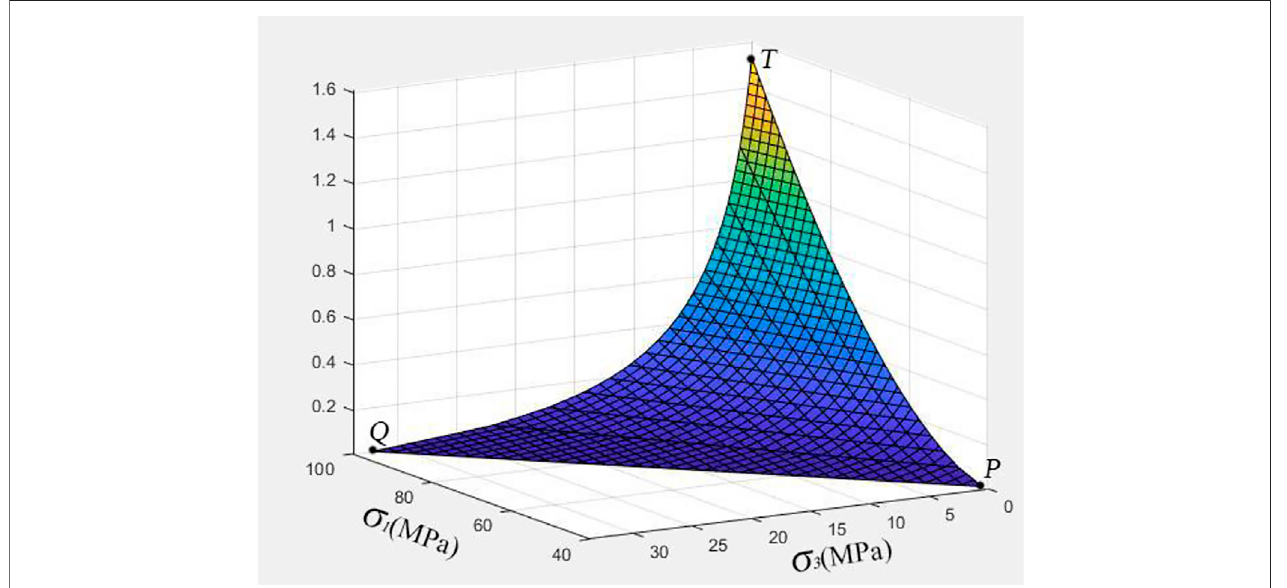
FIGURE 9 | (A) l as a function of σ 1 with σ 3 fi xed. (B) l as a function of σ 3 with σ 1 fi xed ( K IC = 2 MP · m 0.5 and a = 0.01 m).